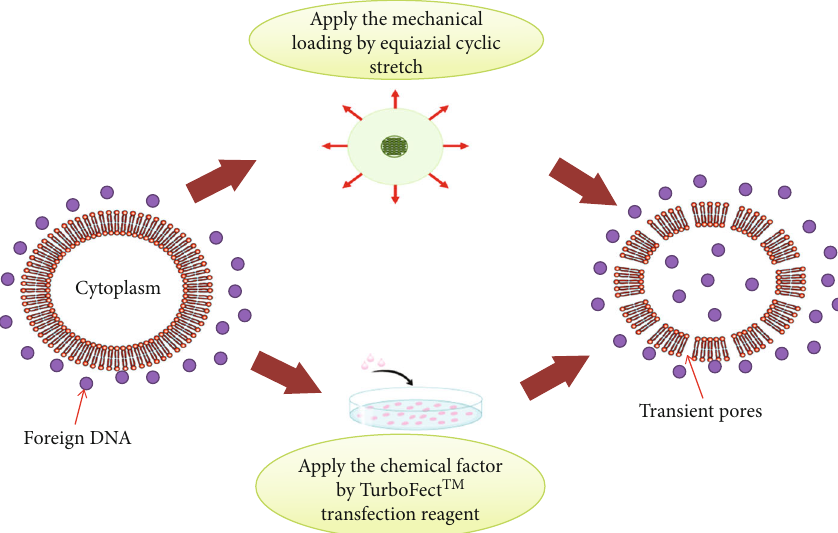
Figure 1: The schematic of the transfection method by the equiaxial cyclic stretch and chemical